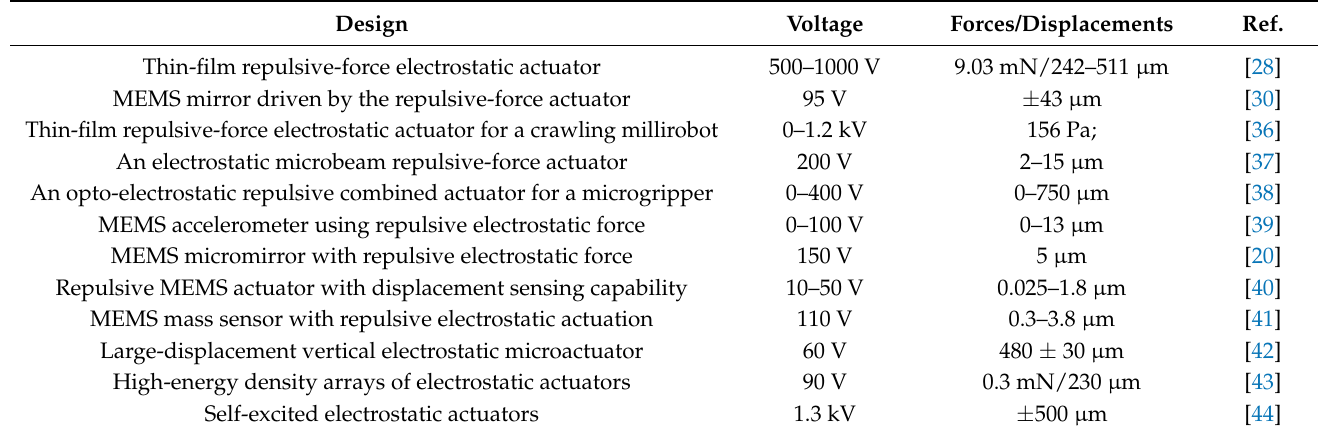
Table 1. Summary of repulsive-force actuators reported in last 5 years.